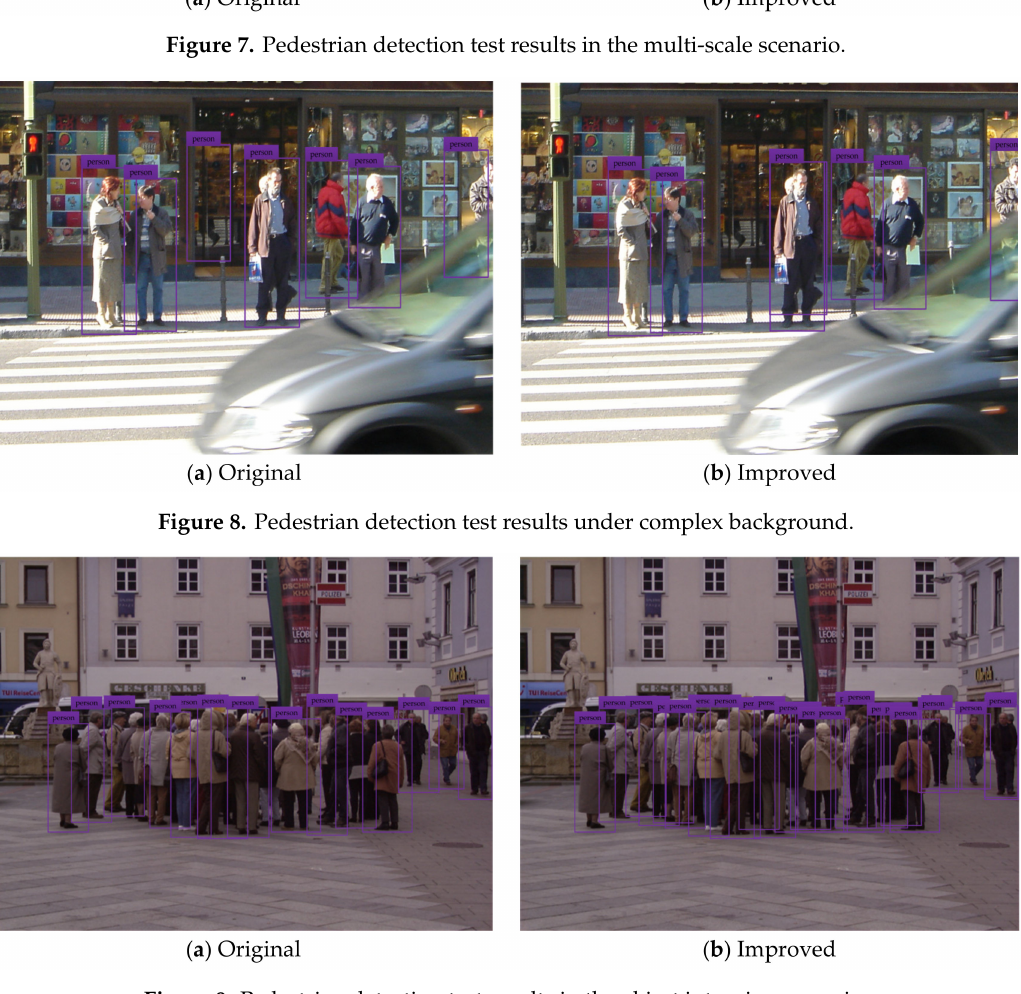
Figure 9. Pedestrian detection test results in the object intensive